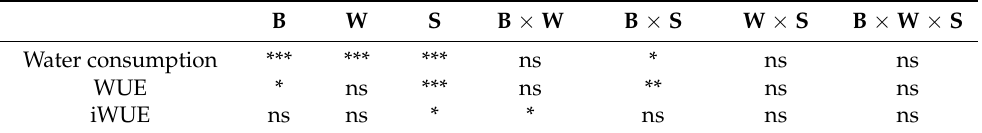
Note: *, ** and *** indicate significance levels at p < 0.05, p < 0.01, and p < 0.001; ns indicates there is no significantly effect at p < 0.05.